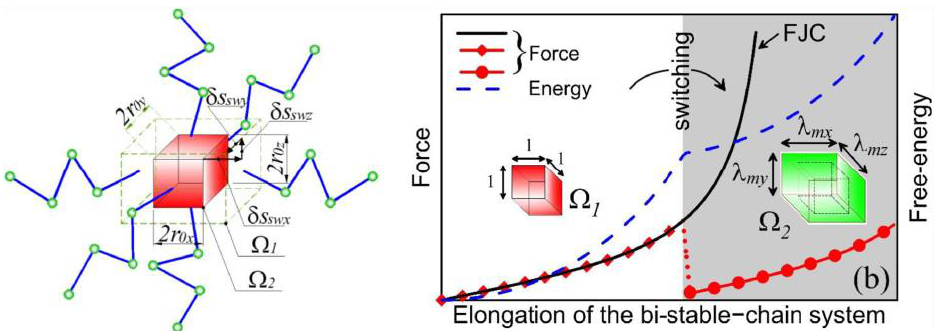
Figure 8. Micromechanical model of polymer network incorporating phase-changing molecules (Adapted with permission from [81]. 2019, Brighenti, R. et al.).